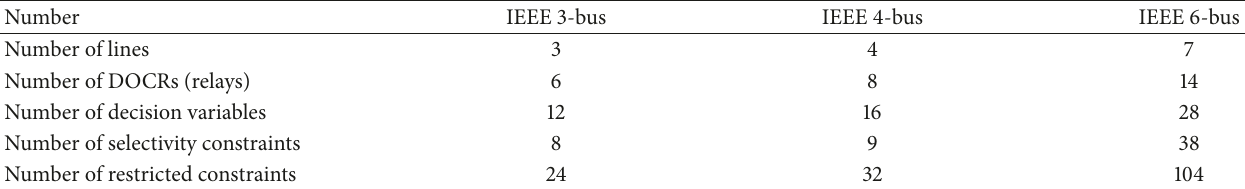
Table 5: The summary table of different components involved in the problem of DOCR.